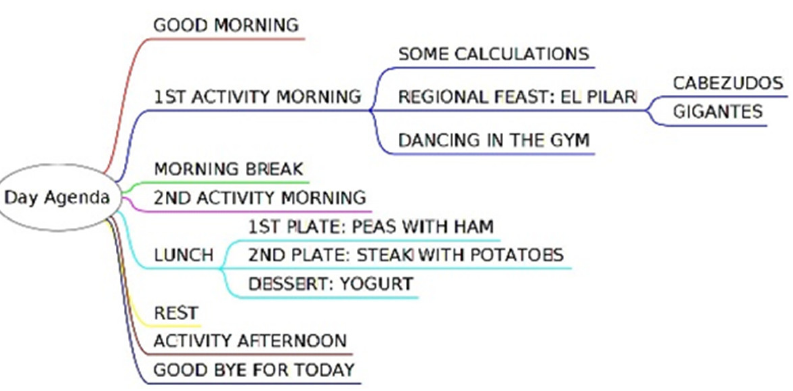
Figure 14. TICO’s hierarchical structure in time orientation allows grading level of detail in agenda. Spatial distribution of elements will mean sequential progress in time, so the position of elements in the phrase means their time location. Some specific elements were added orientation assistive tools.